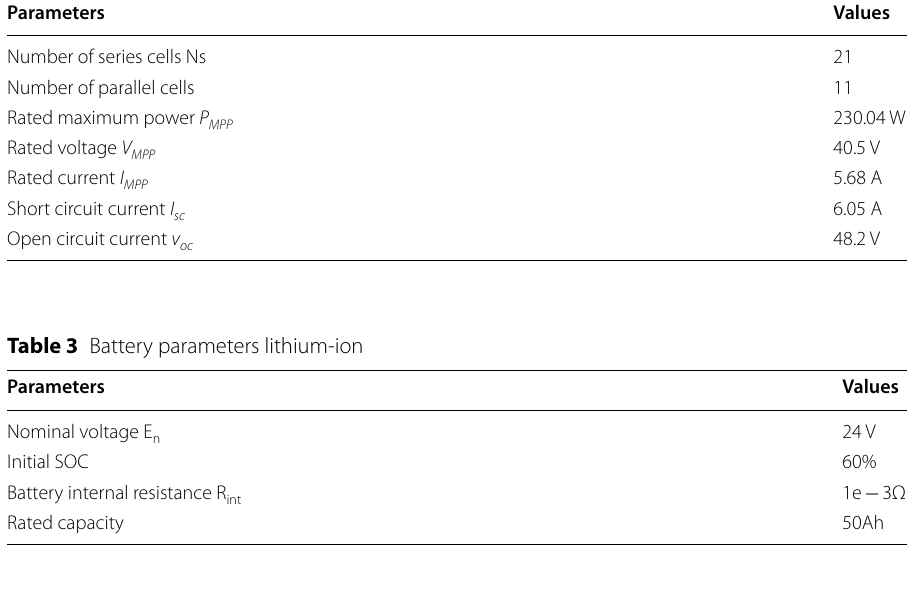
Table 2 PV Sun Power SPR-230E-WHT-D parameters